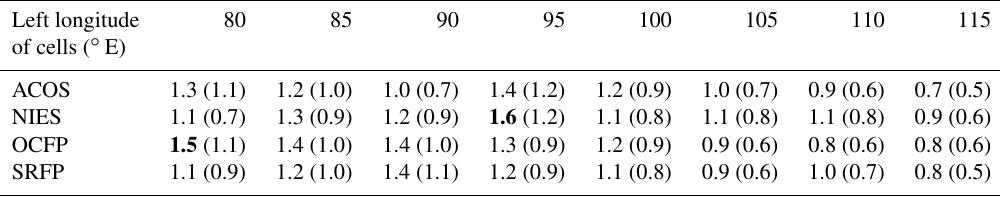
The columns labeled with ∗ represent the left longitude of cells ( ◦ E). Table 5. The average of the absolute differences (ppm) and SD (ppm) of the target algorithm (in column) matching all other algorithms for each cell. Values in parentheses are the corresponding SDs. The differences, which are larger than 1.5ppm, are highlighted in bold. Left longitude